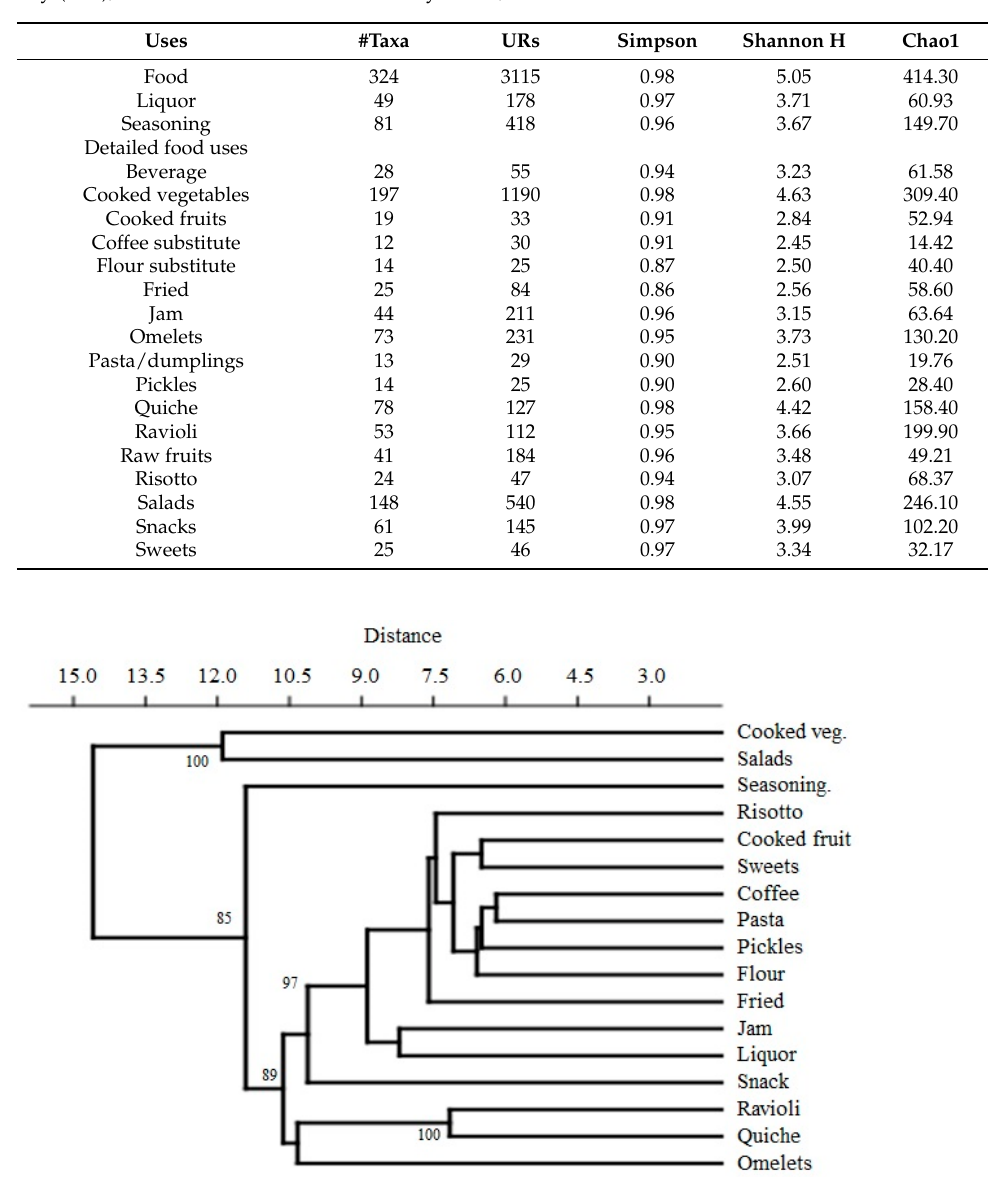
Table 3. Diversity indices calculated for the categories of use and for each food preparation. #Taxa = number of taxa listed; URs = number of use reports; Simpson: Simpson index of diver-